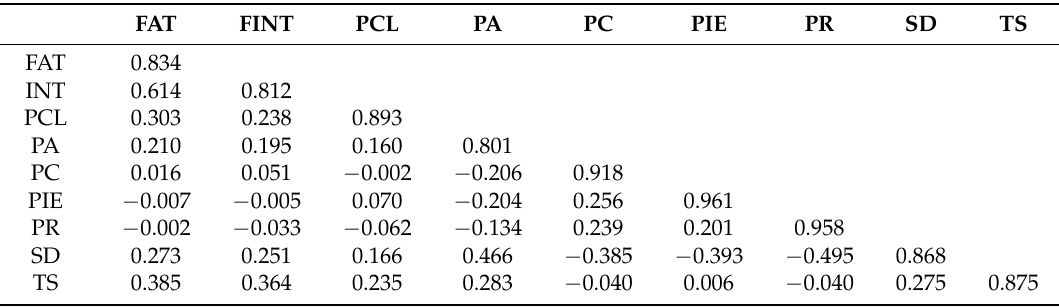
Table 3. Test of discriminant validity using Fornell-Larcker Criterion.